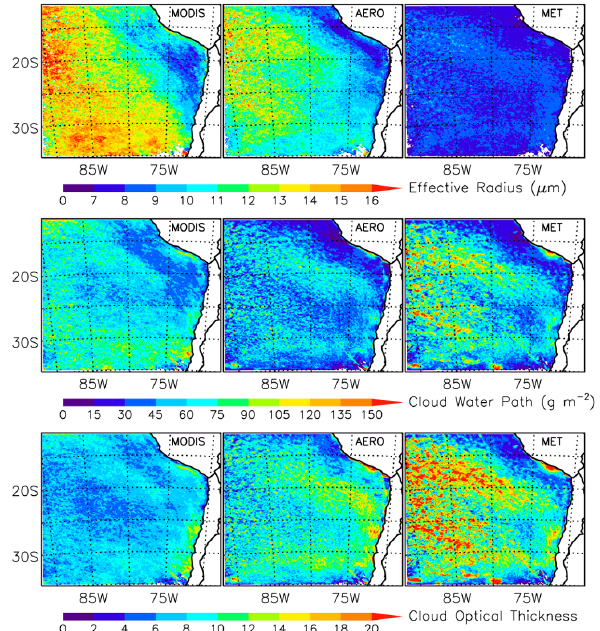
Fig. 7. Effective radius, cloud water path, and cloud optical thick- ness during the VOCALS-REx period from MODIS (Aqua) re- trievals and from the AERO and MET simulations.